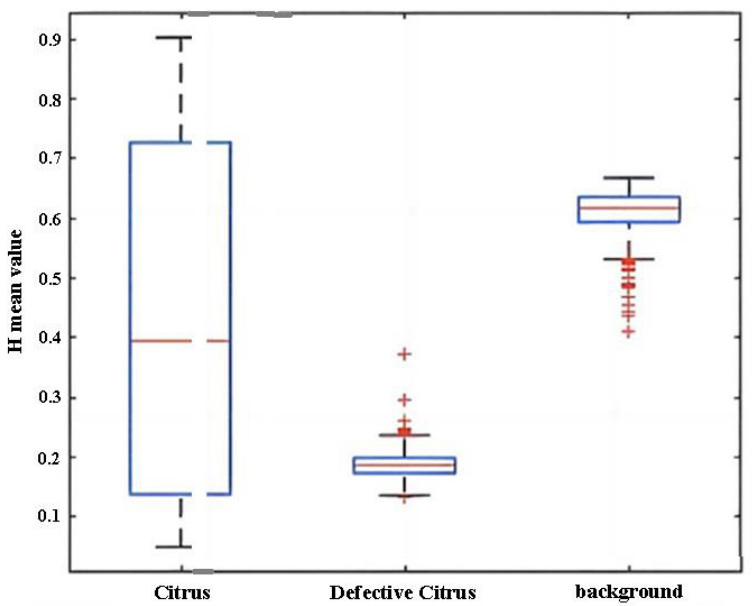
Figure 9. Boxplot of H feature mean. The three red lines of the three blue boxes in the figure are the median of the feature of citrus, defective citrus and background respectively. The two lines above and below the blue box represent the maximum and minimum values of the feature.